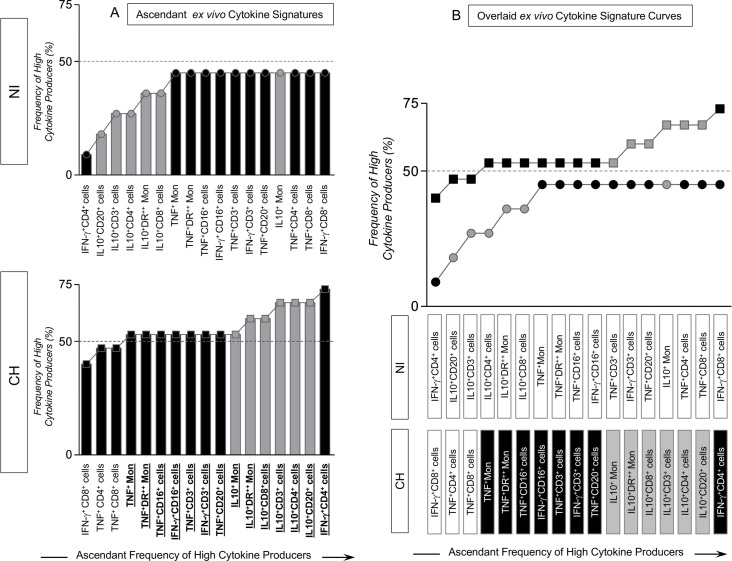
Ascendant ex-vivo cytokine signatures and overlaid comparative analyses of macaques naturally infected with TcI T. cruzi and non-infected macaques.(A) Ascendant ex vivo cytokine signatures assembled to characterize the frequency of high producers within infected monkeys (CH) and non-infected controls (NI). Data are presented by bar charts and continuous lines (NI = circle symbols; CH = Square symbols). The biomarkers with frequencies above the 50th percentile are highlighted by bold underline format and the ascendant construction was used to identify the biomarkers with the most prominent contribution for high cytokine producers. (B) Overlaid cytokine signature curves were plotted for comparative analyses of the overall ex vivo ascendant cytokine pattern of CH and NI. The frequencies of high producers confined above the 50th percentile line were tagged by rectangles to highlight the pro-inflammatory (black rectangle) and modulatory (gray rectangle) cytokine-producing leukocyte subset.